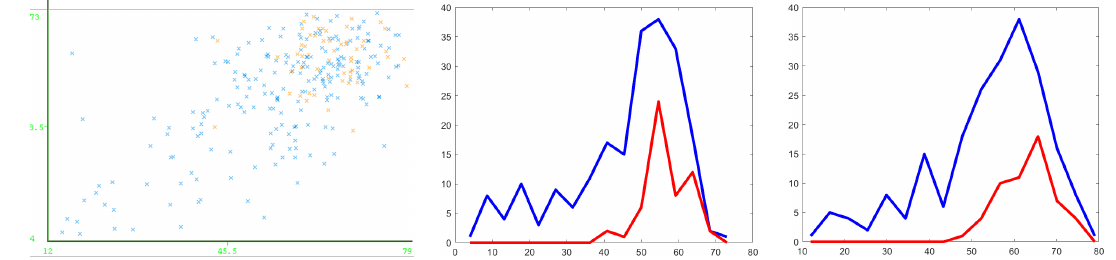
Figure A5. Scatter and Histogram of SPECTF Dataset.